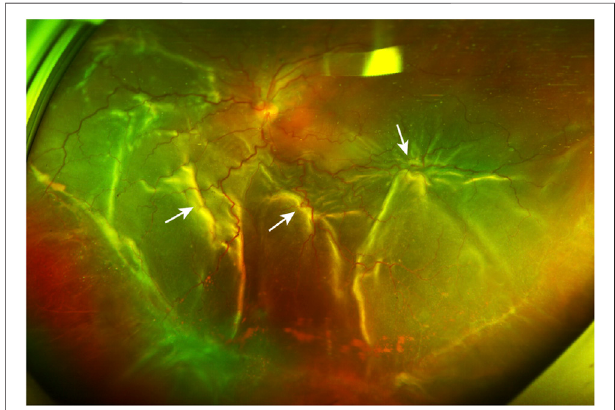
FIGURE 1 | A PVR patient with retinal detachment. The ultra-wide fi eld retinal image shows inferior vitreous hemorrhage and extensive retinal folds (white arrows) caused by PVRMs. PVR, proliferative vitreoretinopathy; PVRM, proliferative vitreoretinopathy